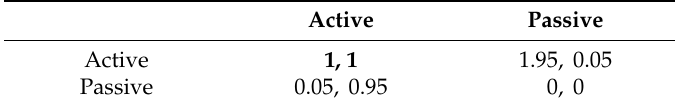
Table 14. Payo ff matrix A for 2 × 2 (Scrum Master vs. OTM) game for the most e ff ective team